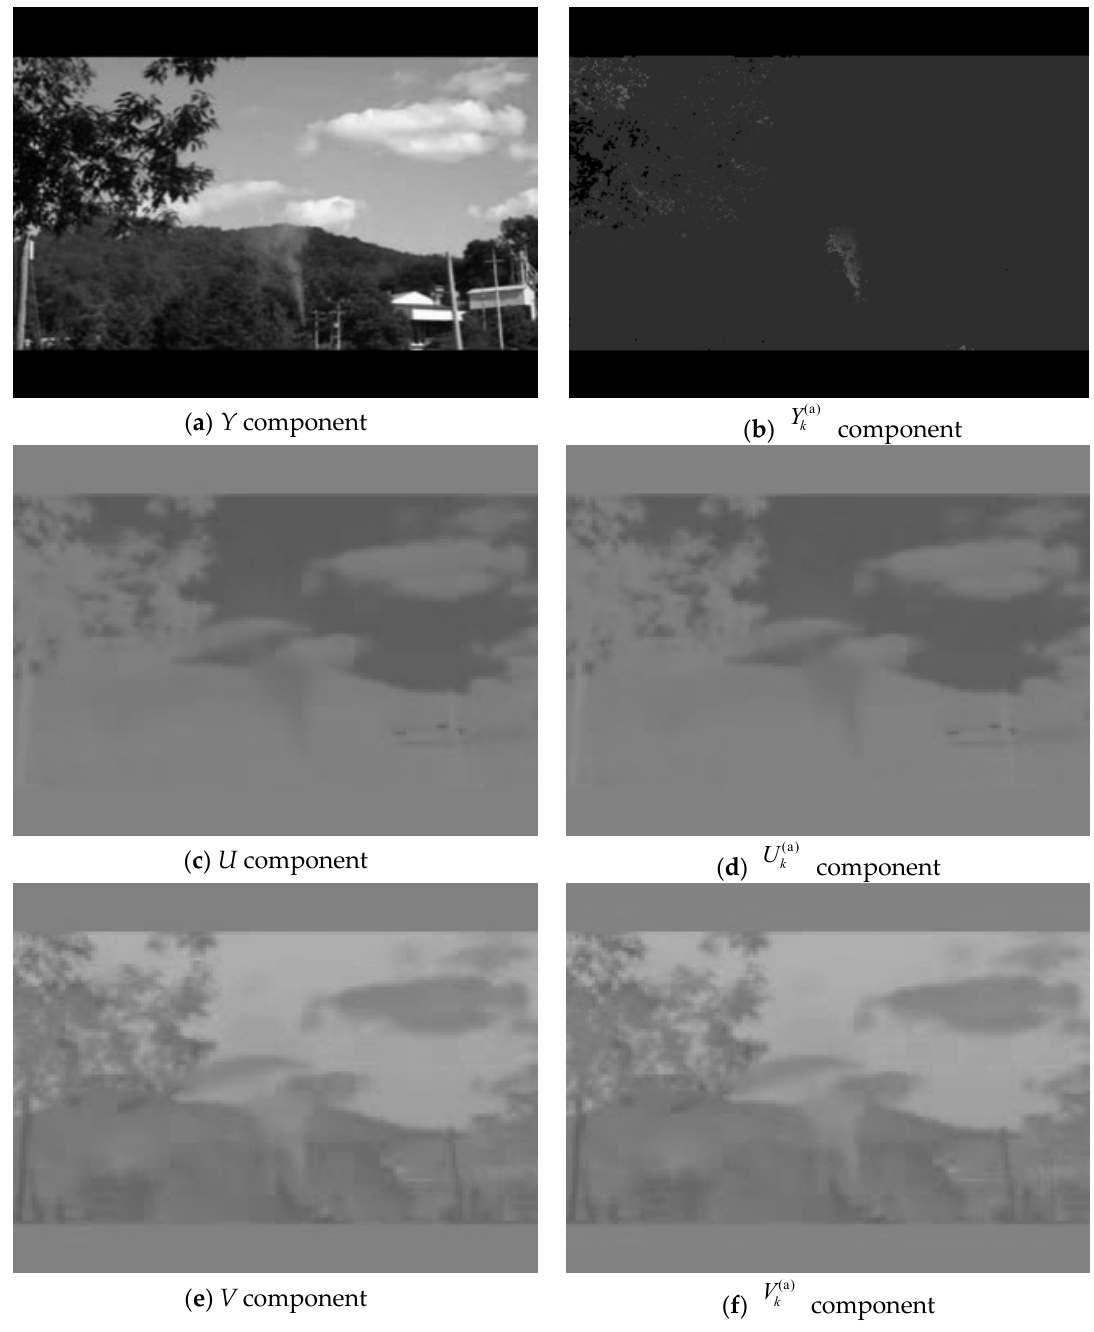
( a ) ( a ) ( a ) U V of the 108th frame in the k k k